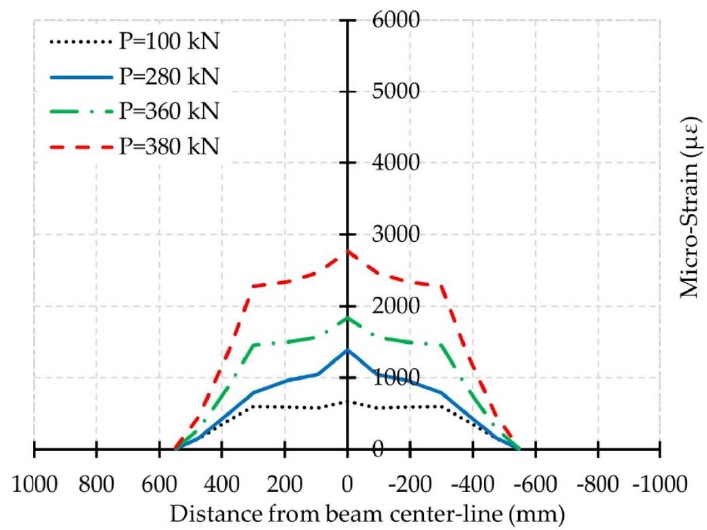
Figure 22. Strain distribution along the HFRP strip of 1170-S-100.